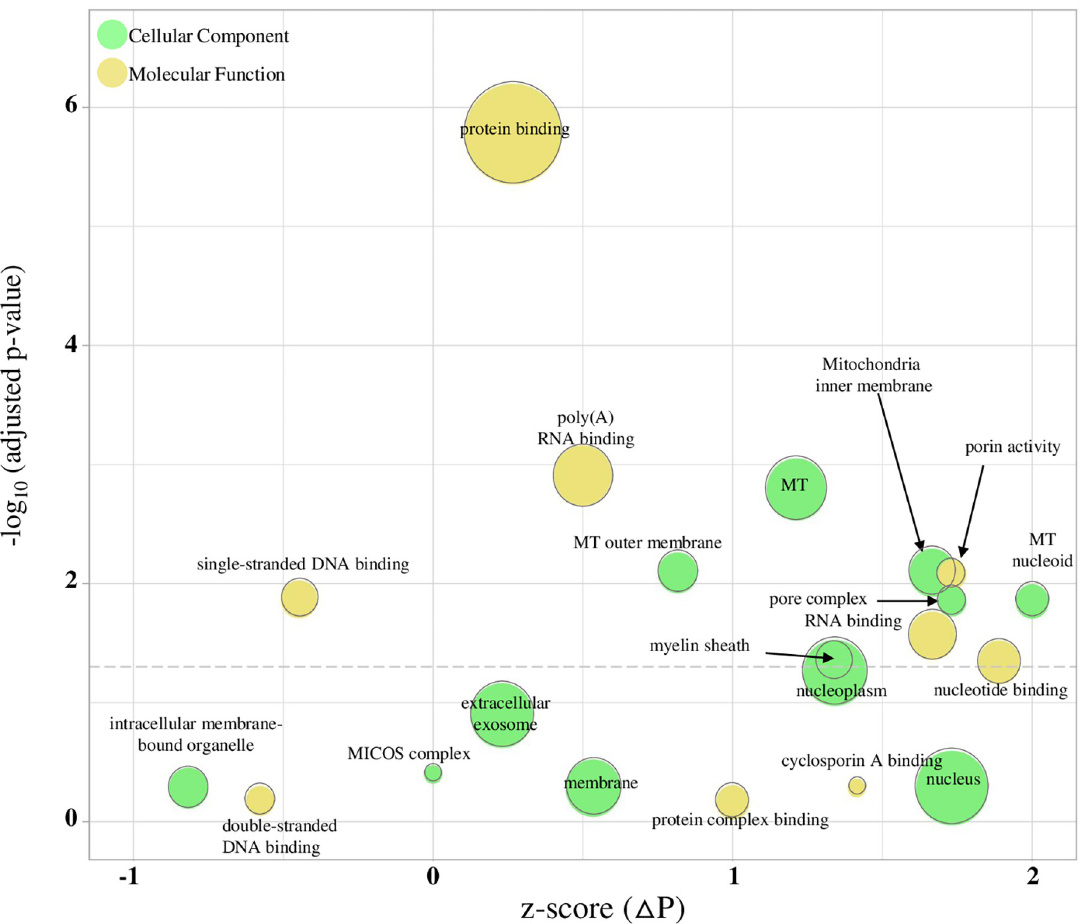
Fig 6. DAVID enrichment analysis of the Δ P proteome. Δ P was identified using the parameters indicated in Fig 1A plot of the DAVID enrichment analysis in which the bubble size describes the number of proteins within Δ P associated with each term. The x-axis is a GOPlot calculated z-score that indicates whether the term is likely increased (z > 0) or decreased (z < 0) based on the log 2 abundance ratios of the proteins within the GO term. Terms that fall below the dotted grey line do not reach statistical significance as determined by an adjusted p-value � 0.05 by Benjamini-Hochberg